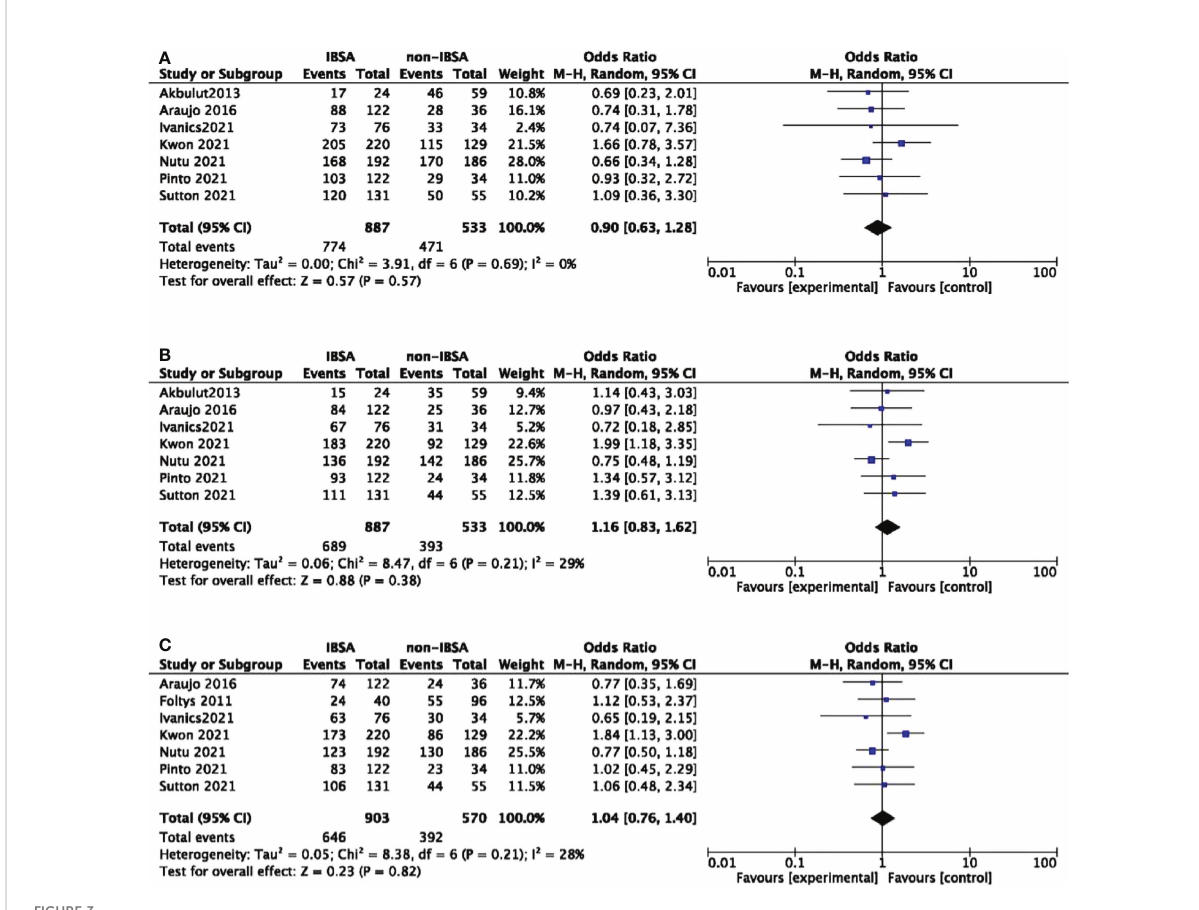
FIGURE 3 Meta-analysis forest plot of the overall survival. (A) , 1-year OS; (B) , 3-year OS; (C) , 5-year